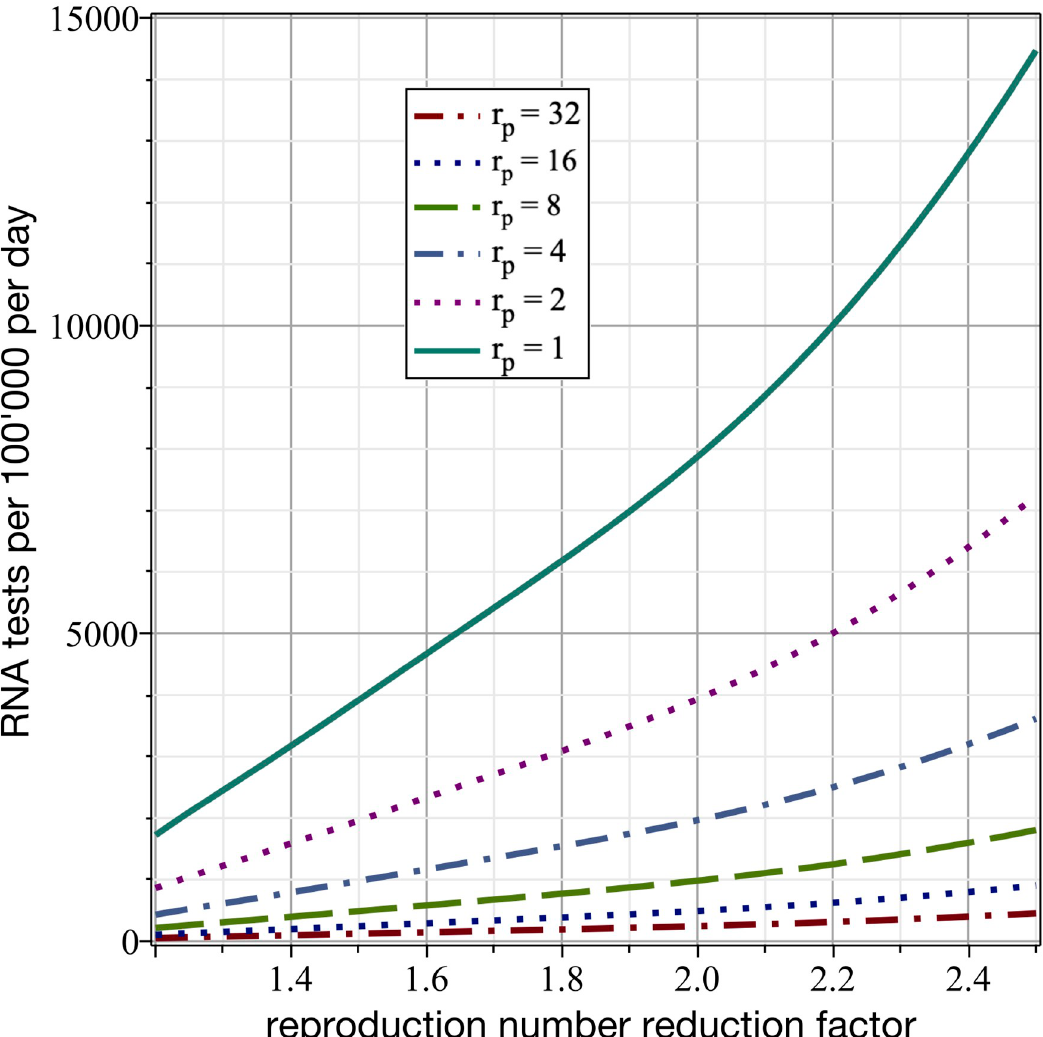
Fig 2. Numbers of required virus RNA tests per 100’000 people per day for ST to achieve a specified reproduction number reduction factor depending on the ratio of positive predictive value to the overall population prevalence. A 5% false negative rate and one day delay is assumed for the virus RNA